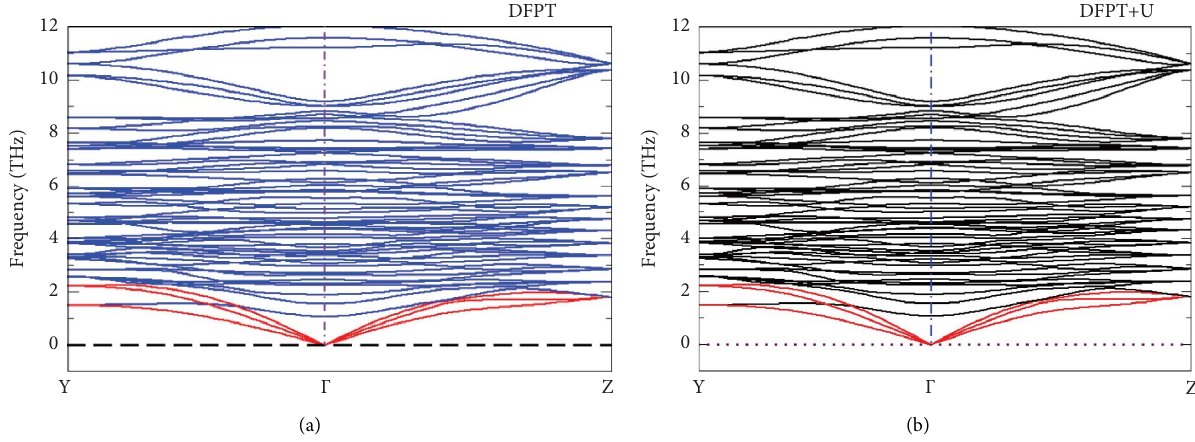
Figure 5: Phonon dispersion relation for CaHfS